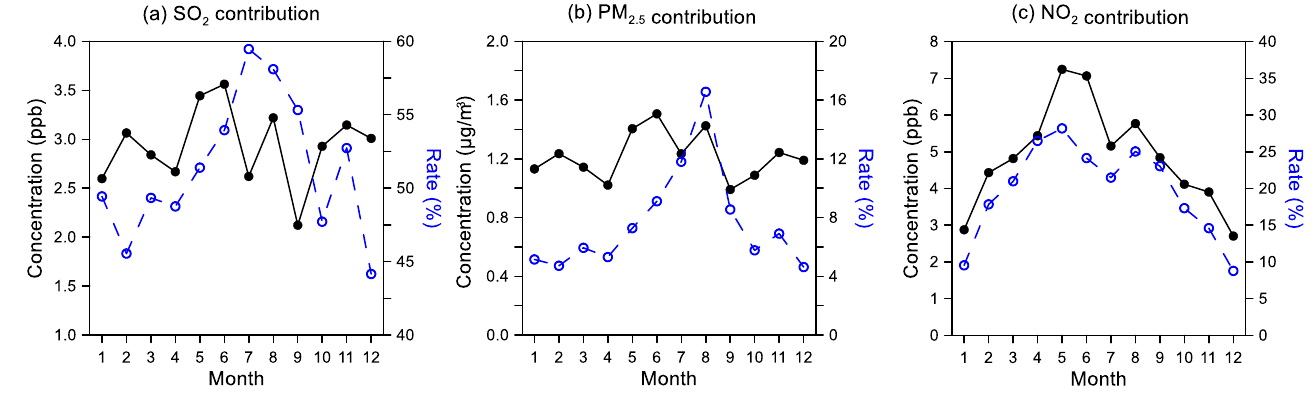
Figure 6. Monthly contributions of ( a ) SO 2 , ( b ) PM 2.5 , and ( c ) NO 2 derived from ship emissions in Busan.